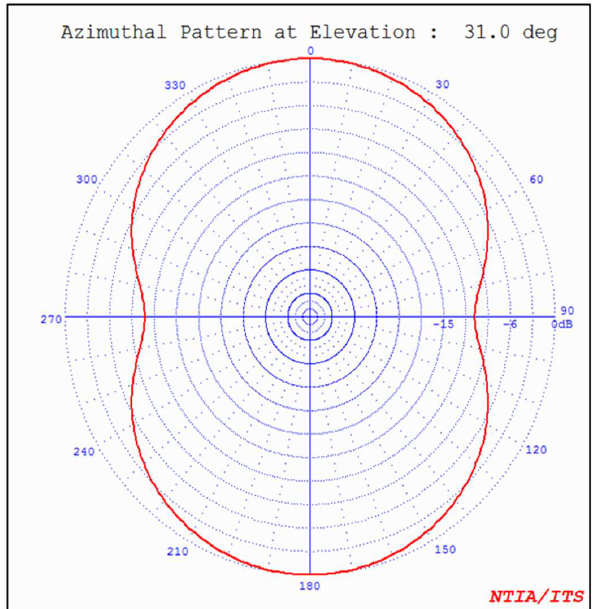
Fig. 6.b Shows HFant results (azimuth